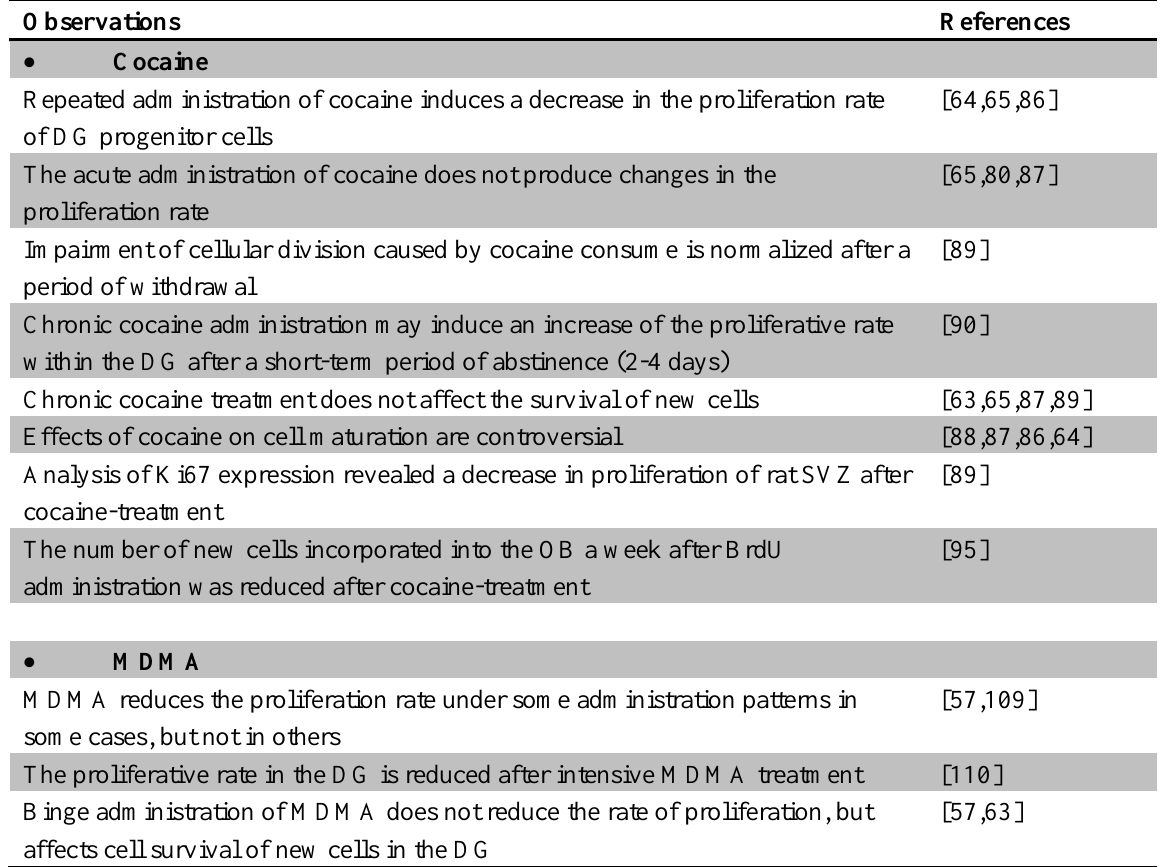
Table 1. Effects induced by cocaine and MDMA in adult